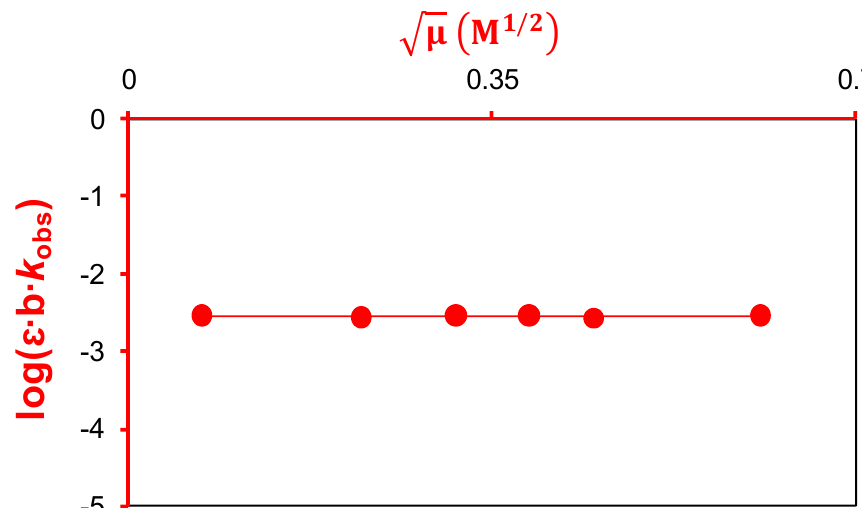
Figure 5. Plot of the effect of ionic strength on the observed rate constant.